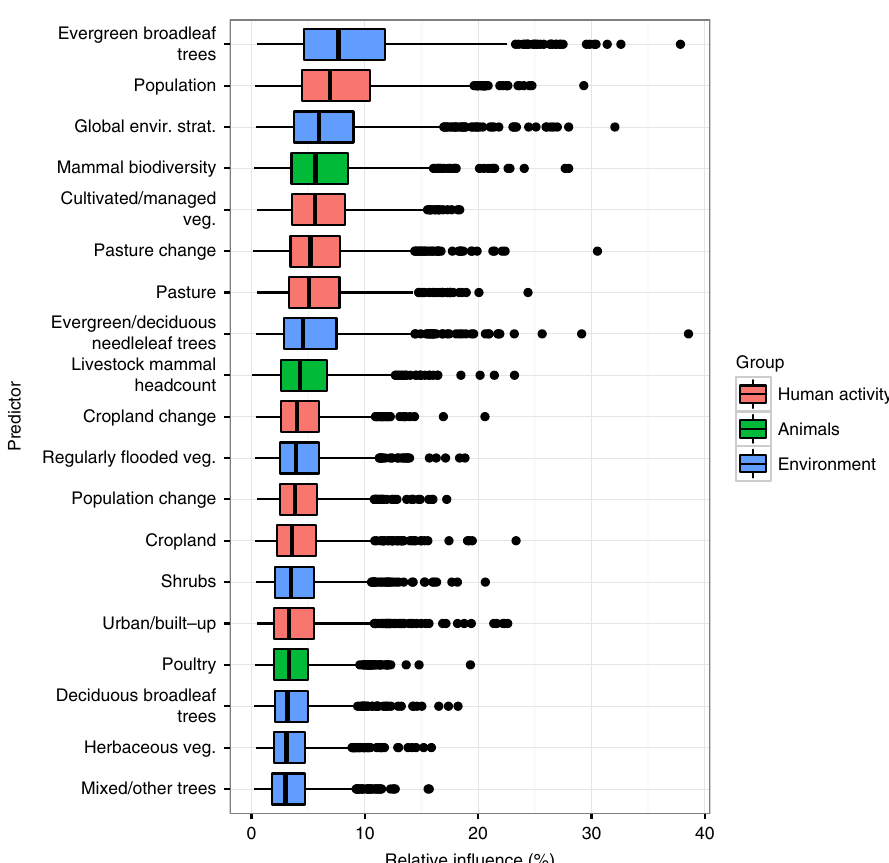
Fig. 1 The relative in fl uence of predictors on EID event occurrence probability. The box plots show the spread of relative in fl uence across 1000 replicate model runs to account for uncertainty in EID event location (see above). Whiskers represent the minimum or maximum datum up to 1.5 times the inter- quartile range beyond the lower or upper quartile. BRTs do not provide p -values or coef fi cients, but rank variables by their relative in fl uence in explaining variation in the outcome